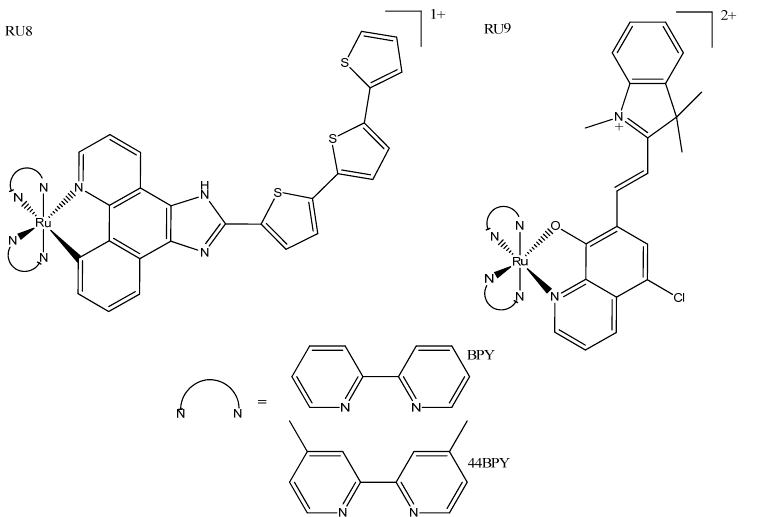
Figure 7. Cyclometallated ruthenium complexes RU8a and RU8b, where N^N = 44BPY or BPY, respectively [59,60]; N^O complex RU9, where N^N = BPY [61].